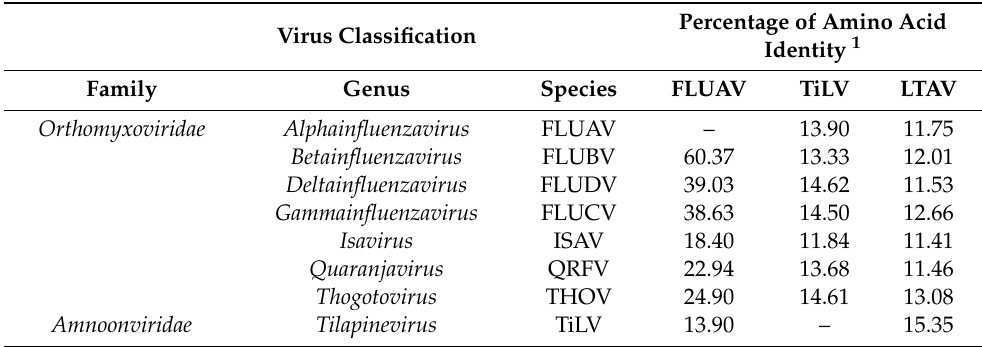
Table 2. Percentage of identical residues among members of the order Articulavirales and Lauta virus